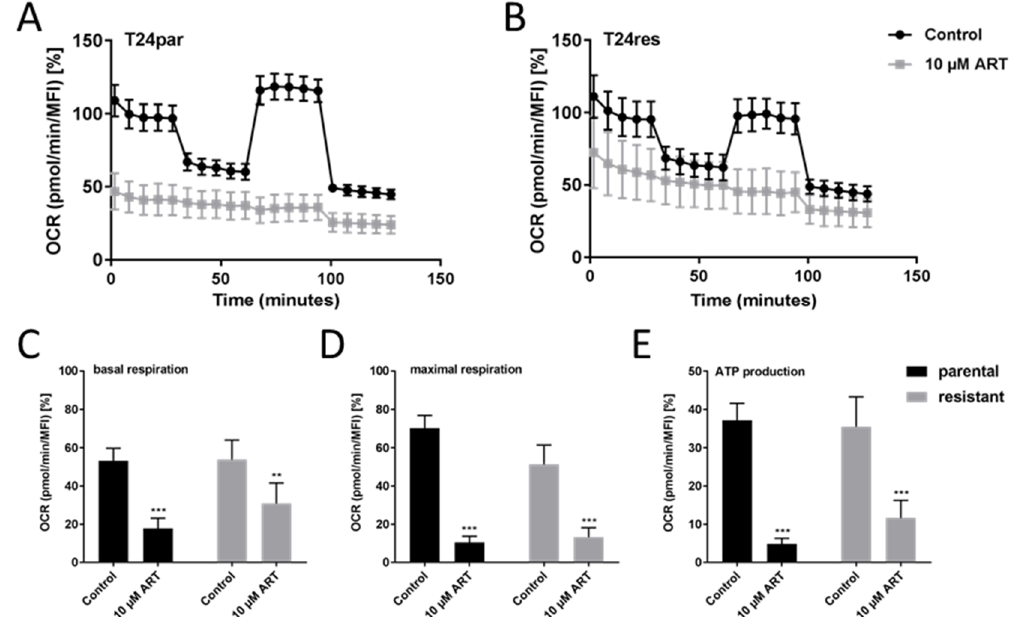
Figure 5. Mitochondrial respiration: Mitochondrial respiration in parental ( A ) and resistant ( B ) T24 cells, 24 h exposed to ART, compared to untreated controls. Data pertaining to the OCR were normalized to total basal respiration (set to 100%) consisting of mitochondrial and non-mitochondrial respiration. Extracted values for mitochondrial basal OCR ( C ) and maximal OCR ( D ) and ATP production ( E ) after ART treatment. MFI = mean fluorescent intensity. Error bars indicate standard deviation ( SD ). Significant difference to untreated control: ** p ≤ 0.01, *** p ≤ 0.001. n = 3.